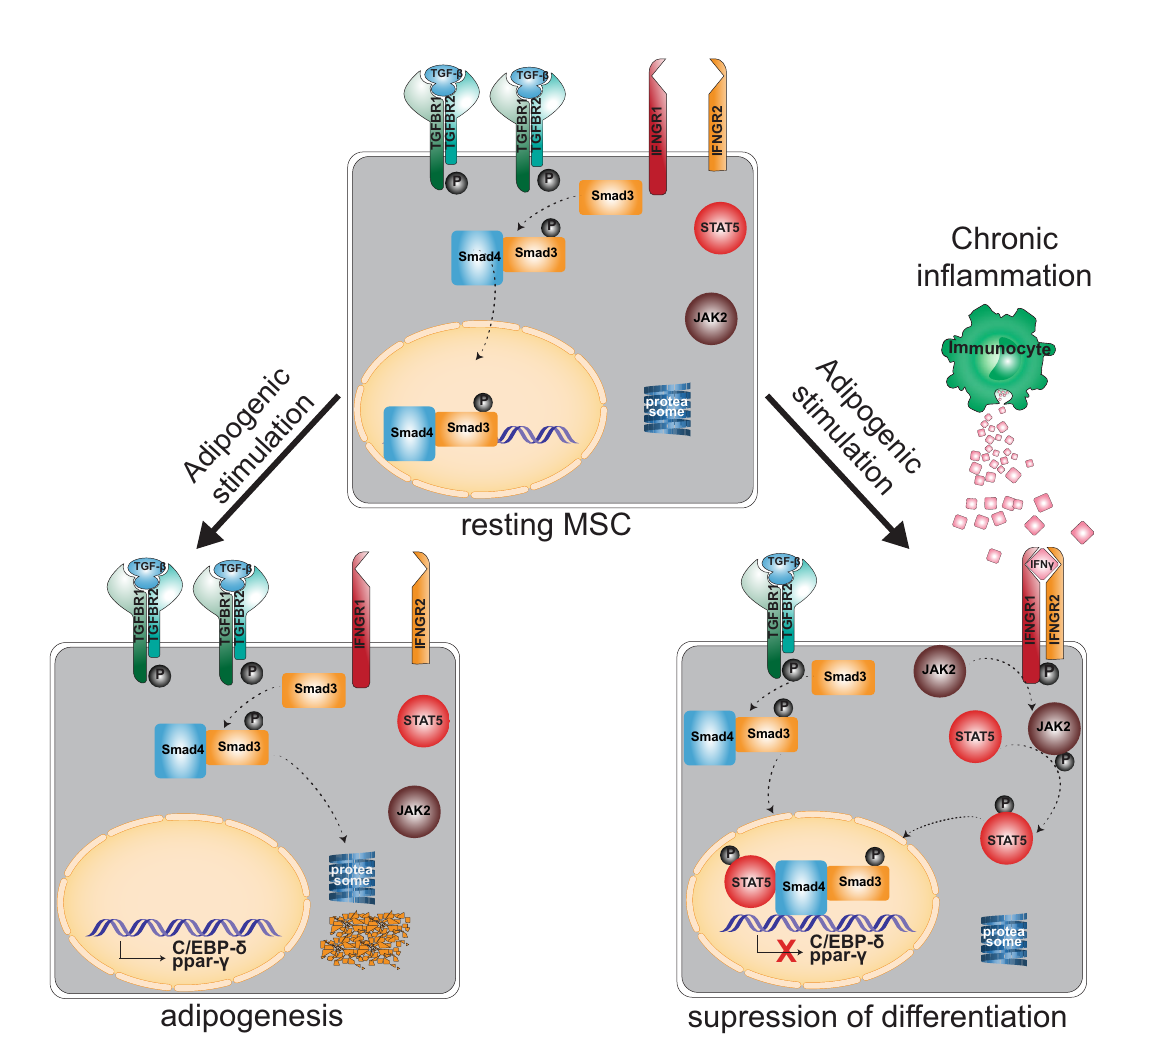
Fig. 6 Murine model of VA-MSC adipogenic suppression under chronic in fl ammation supports the central role of STAT5 – Smad3 synergy. a , b Representative ( N = 3) fl ow cytometry Analysis of MSC-speci fi c marker expression in WT mVA-MSC ( a ) and γ R1KO-mVA-MSC ( b ). Unshaded peaks represent isotype control, shaded peaks represent cells stained with the antibodies mentioned. These cells show a marker phenotype of CD105 + CD44 + CD29 + Sca1 + CD73 − CD45 − CD11b − MHCII − . ~60,000 – 80,000 cells were used/sample. c Representative ( N = 3) phase-contrast microscopy of mVA- MSCs after 7 days of adipogenic induction with/out murine IFN γ (10 ng/ml). Bright globules are lipid droplets. d Representative western blot analysis ( N = 2) of mVA-MSC lysate after 7 days of adipogenic induction. Murine IFN γ was used at 10 ng/ml. e Representative ( N = 3) phase-contrast microscopy of WT mVA-MSC after 7 days of adipogenic stimulation with/out murine IFN γ (10 ng/ml) with inhibitors (Ruxolitinib — 5 µM; STAT5i — 200 µM, Galunisertib — 20 µM). f , g Representative H&E stained images ( f ) and quanti fi cation of adipocyte size ( g , N = 3/group) from fat pads of age-matched (~25 weeks old), ND, and HFD-fed male animals. (Inset; γ R1 KO HFD- higher magni fi cation (×40) image of the hyperplasic region). h Oral glucose-tolerance test (oGTT) of ~25 weeks HFD-fed WT and γ R1 KO animals. Area under curve (AUC) analysis of the curves are shown. N = 5 animals/group ( i ) plasma insulin measurement during oGTT of ( h ). Error bars represent mean ± SEM. * indicates statistical signi fi cance (* P < 0.05, ** P < 0.005; *** P < 0.0005; **** P < 0.00005) of multiple unpaired t tests for ( g ); for ( h – i ), (* P < 0.05; ** P < 0.005) of Sidak ’ s multiple comparison test followed by two-way ANOVA.